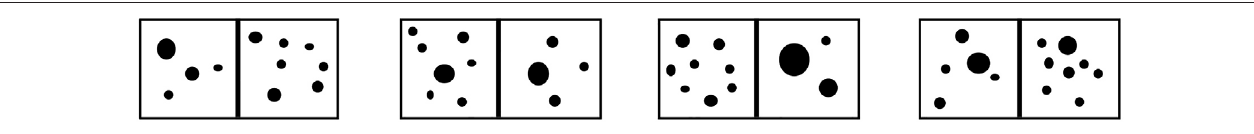
FIGURE 2 | Example of dot array pairs from the number comparison probe. Child draws a line through the array in each pair with more dots working as quickly as